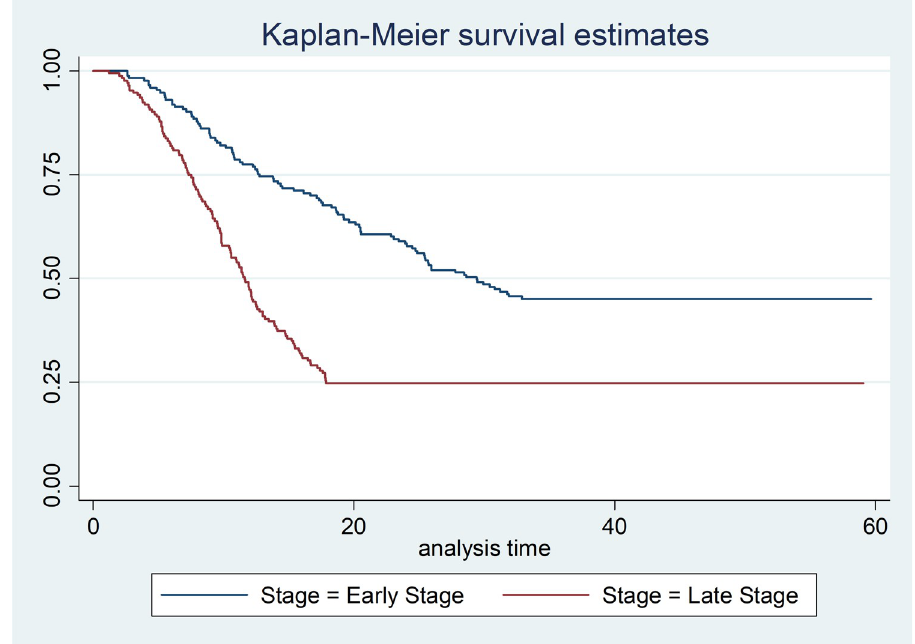
https://doi.org/10.1371/journal.pone.0264369.g001